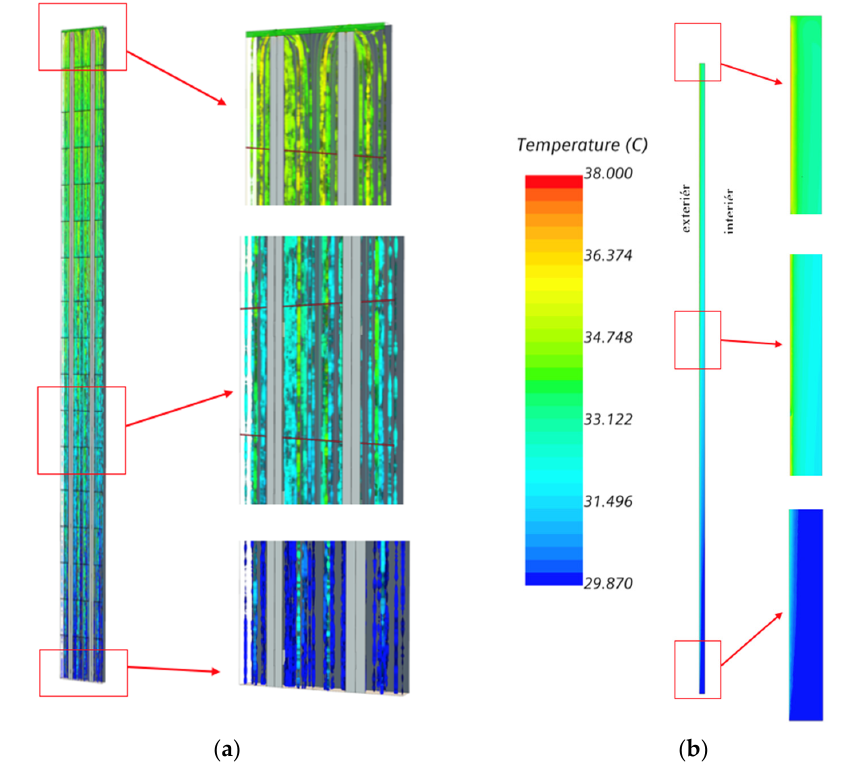
Figure 8. ( a ) Visualization of streamlines in ventilated gap—3D view, ( b ) Visualization of temperature field in façade vertical cross section in summer temperature extreme.